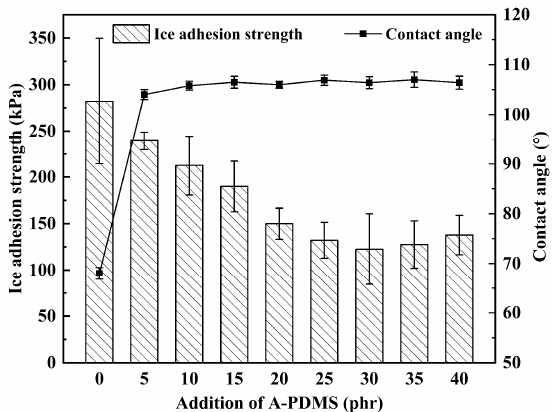
Figure 4. Ice adhesion strength ( τ ice ) ( − 10 ◦ C) and CA of A-PDMS-modified epoxy coatings. The error bar is one standard deviation.